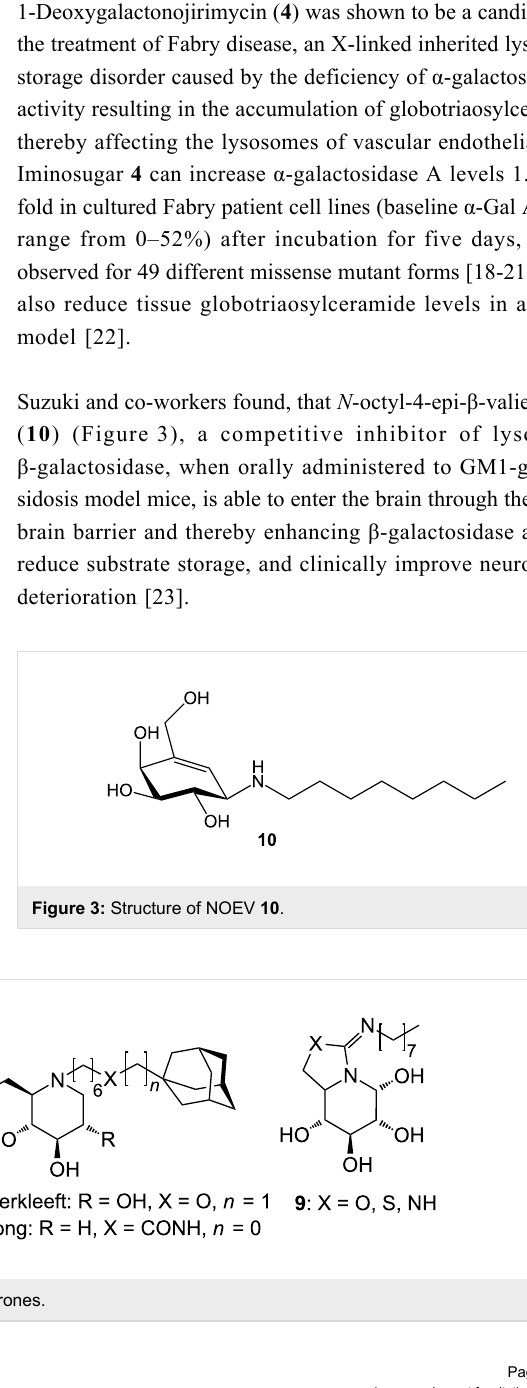
derivatives have been prepared for biological evaluations via a wide range of synthetic approaches and have been used for various medicinal and biomolecular applications [1-9].